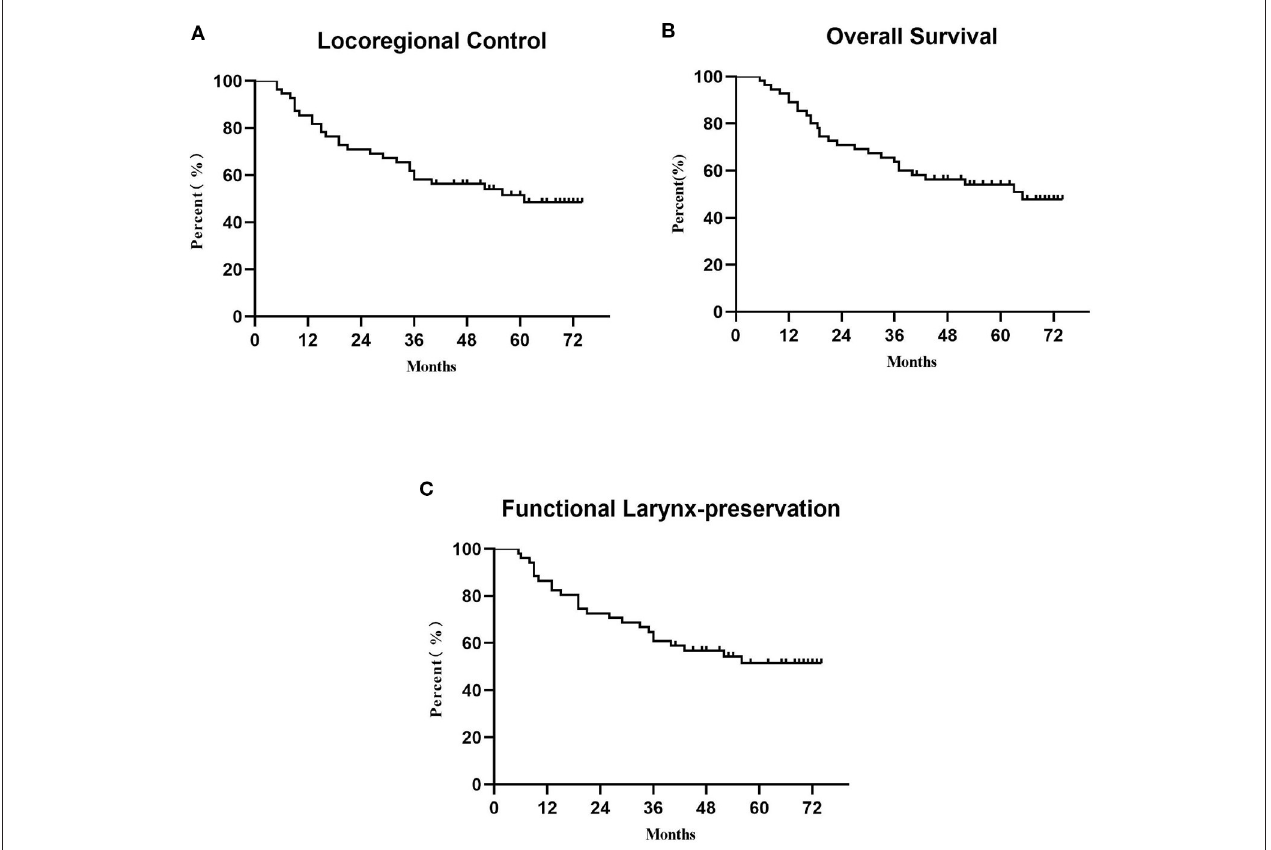
FIGURE 2 | Survival analysis: (A) locoregional control, (B) overall survival, and (C) functional larynx